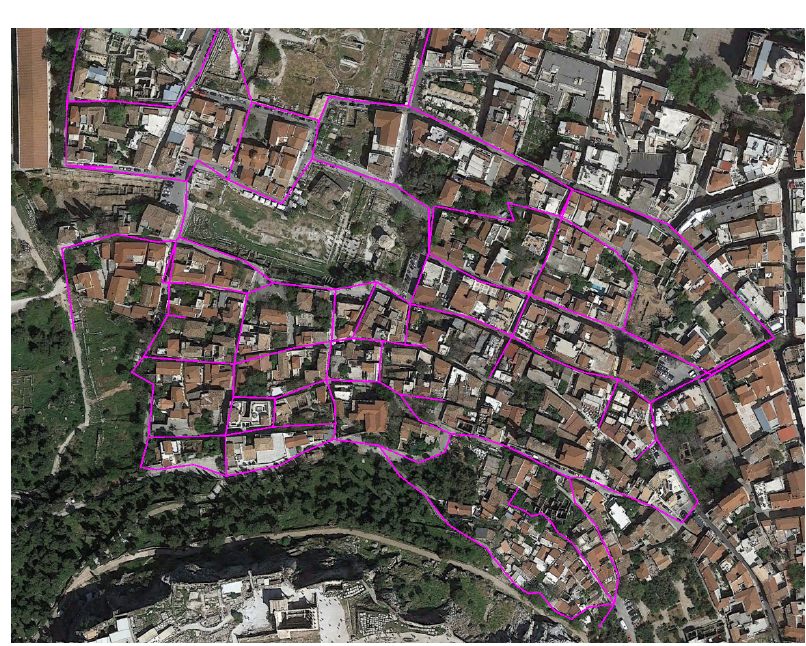
Figure 16: Reference network over satellite image.